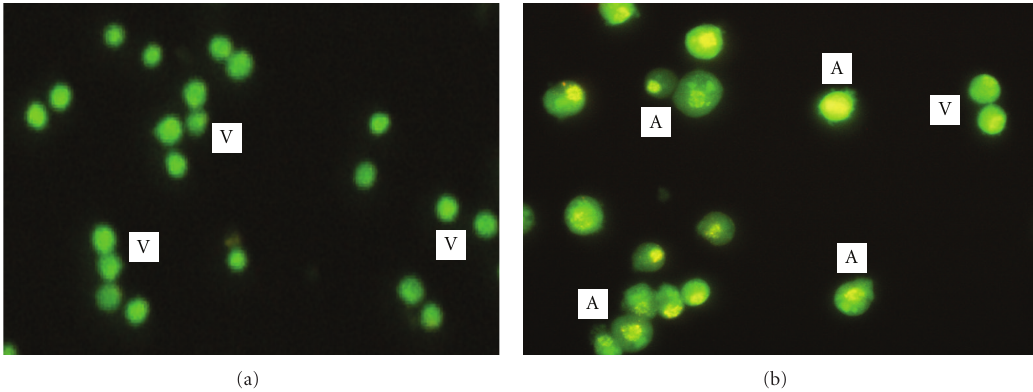
Figure 7: Morphology features of HL60 cells incubated with pyranocycloartobiloxanthone A ( 1 ) after being stained with acridine orange and propidium iodide were observed under fluorescence microscope (magnification 200x) (a) untreated HL60 cells (b) treated with pyranocycloartobiloxanthone A ( 1 ) at 2 μ g/mL (IC 50 value), after 72 hours. Note: V: viable, A: apoptosis, and N: necrosis.